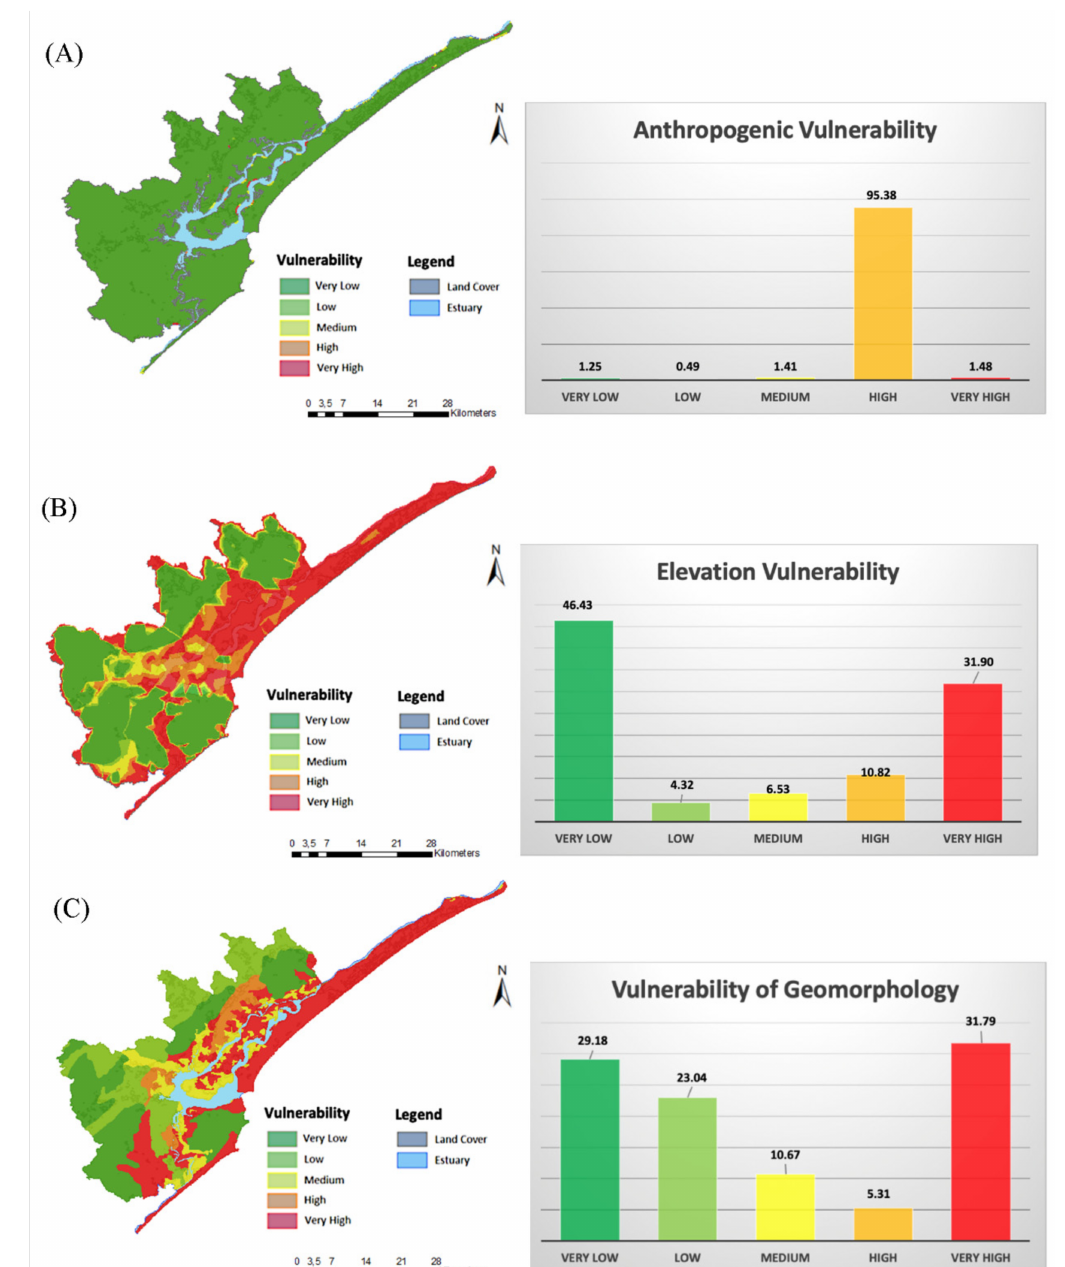
Figure 3. demonstrated the vulnerability associated with each